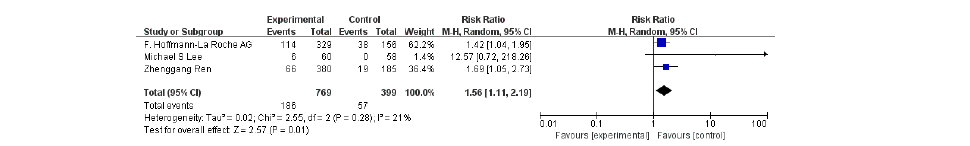
FIGURE 8 Forest plot of the incidence of hypertension (grade 1-2) in patients with HCC treated with ICIs and antiangiogenic drugs in combination or alone.